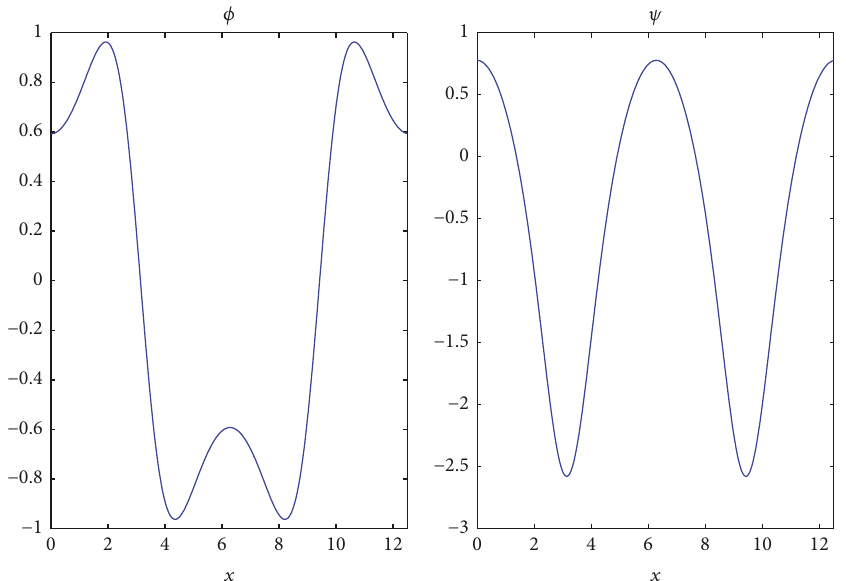
Figure 6: Approximations of the functions 𝜙,𝜓 in the travelling wave solution (39) with 18 Newton’s iterations. The model’s parameters are 𝛼 = 𝛽 = 𝛾 = 1 , 𝑤 = 0.06 , and wave speed 𝑐 = 1 and the fundamental period is 𝐿 ≈ 12.57